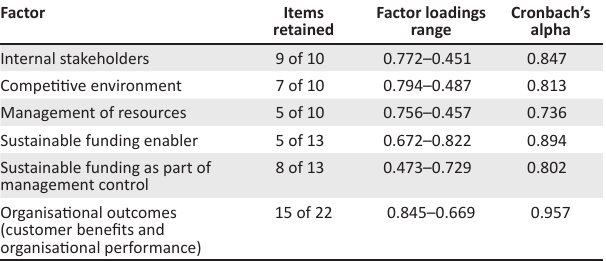
TABLE 1: Validity and reliability